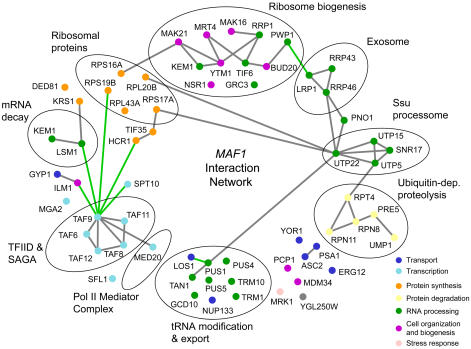

MAF1 genetic interaction network.Genetic and physical interactions from BioGRID are shown between MAF1 SSL genes identified in screens of the essential and non-essential strain arrays. Nodes are colored by Bioprocess. Circles identify well-defined protein complexes except for the tRNA modification & export group where the genes are related by biochemical function. Two MAF1 SSL genes (FYV5 and YGL007W) that lacked interactions in the BioGRID database are not shown in the figure. Genetic interactions are shown in green and protein-protein interactions determined by affinity purification are shown in gray.